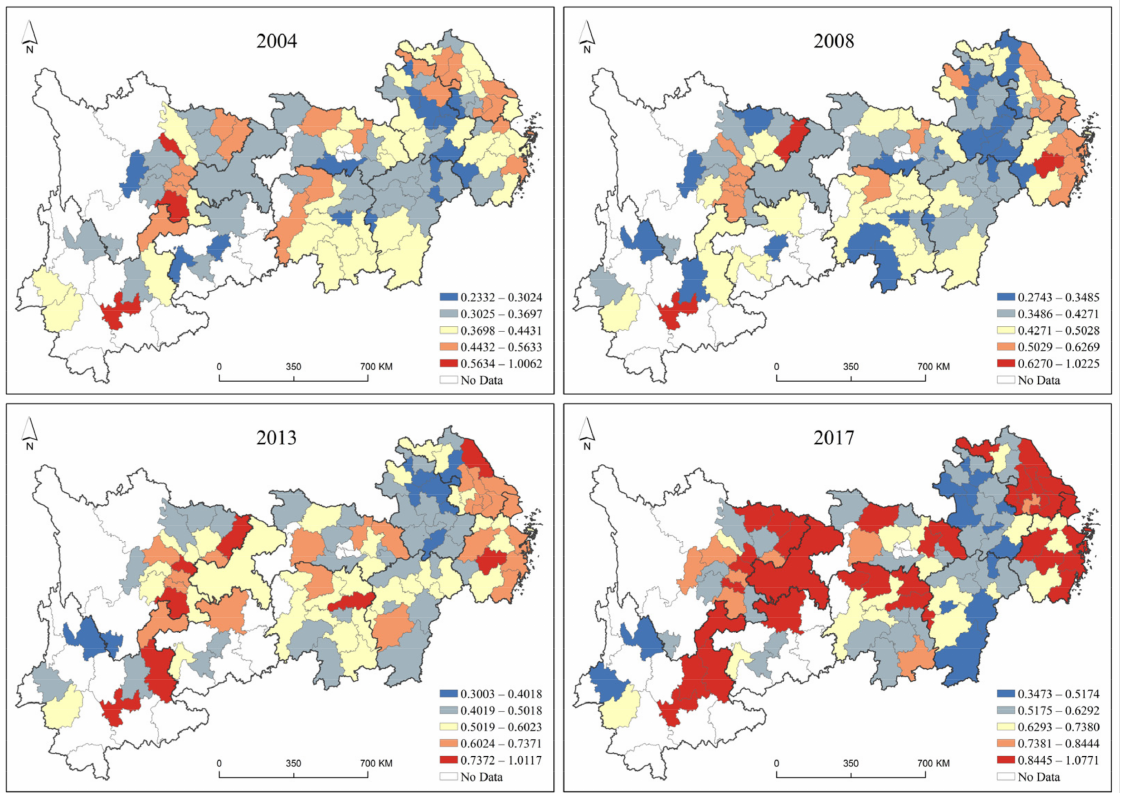
Figure 7. Spatial and Temporal Patterns of Green Development Efficiency.